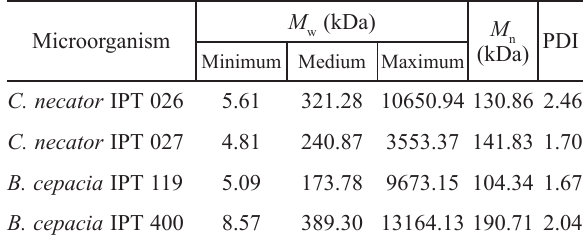
Table 5 – Molar mass of PHA produced by the C. necator and B. cepacia strains from crude palm oil